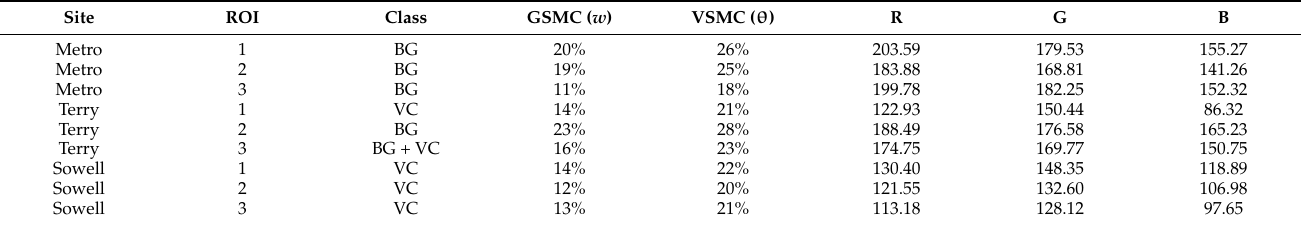
Table 2. Average RGB and soil moisture content variation at 9